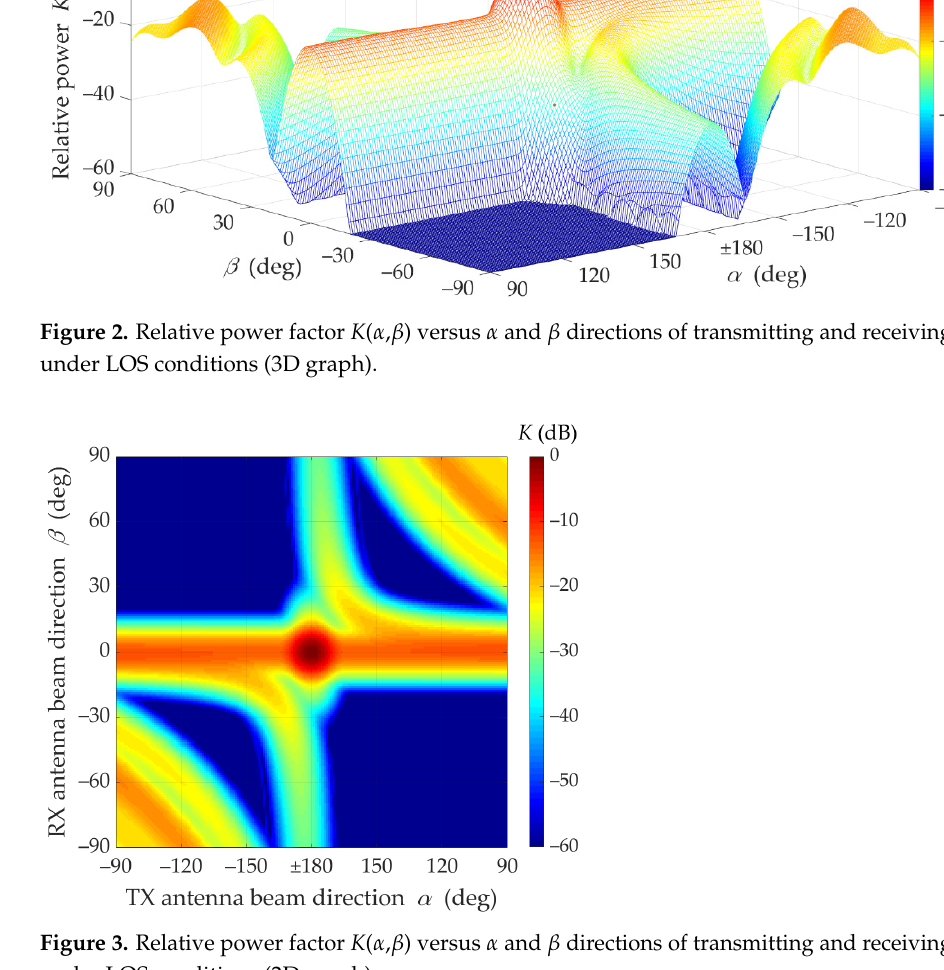
Figure 4. Received signal power losses due to mismatch of transmitting beam direction under LOS conditions. In the analyzed LOS conditions, the Rician factor is equal to 13.3 dB. This means that the first time-cluster in the PDP is dominant. Thus, the direct path (i.e.,